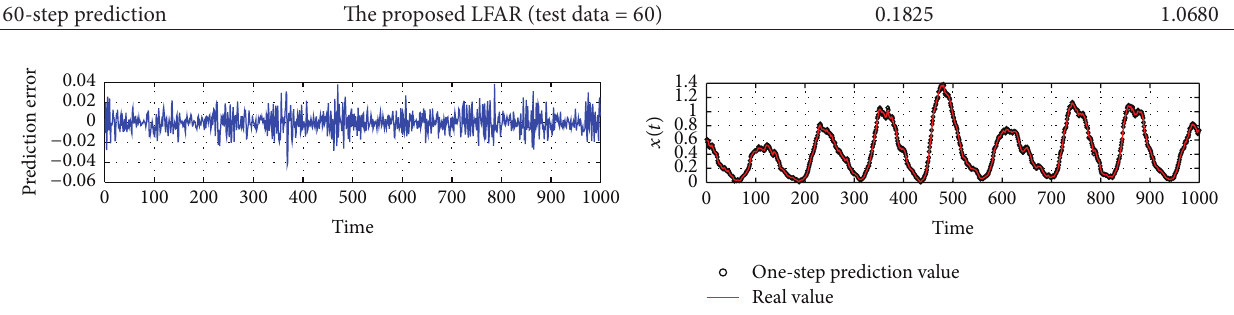
Figure 11: Results of Sunspot time series: (a) single-step prediction error and (b) the original and single-step prediction values, respectively.